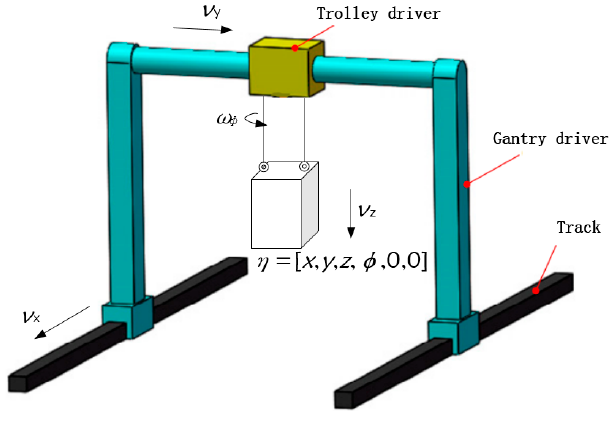
Figure 3. Schematic model.